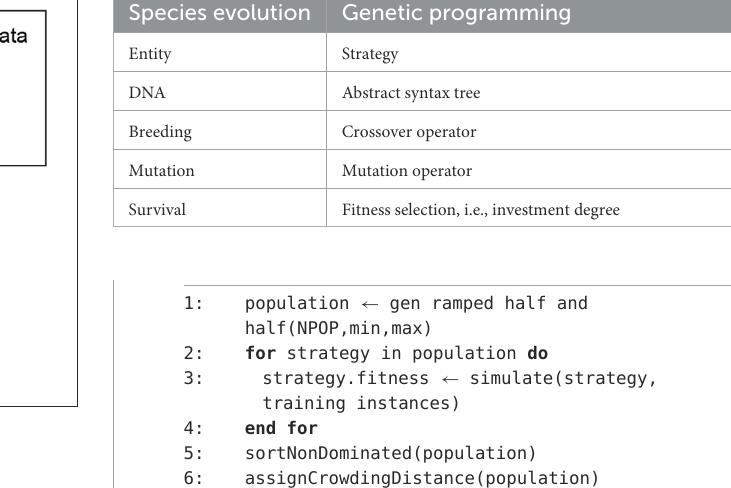
TABLE 1 Parallel with Darwinian evolution. Species evolution